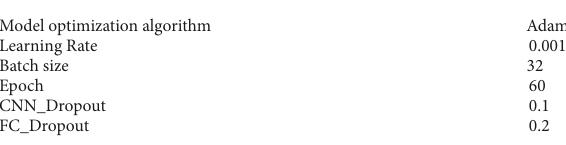
TABLE 7 Hyperparameters design of